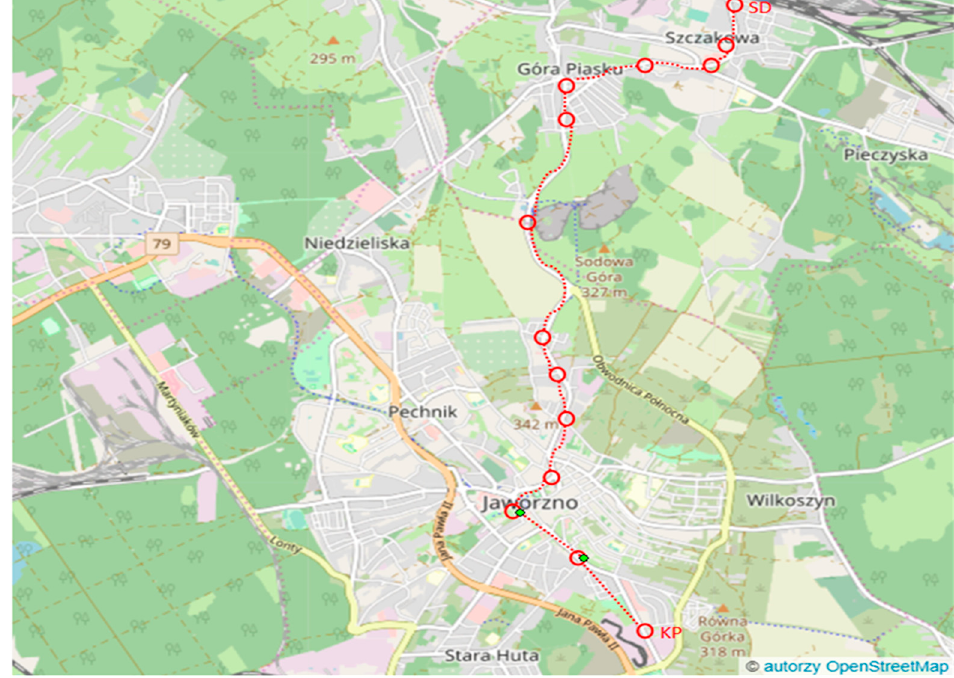
Figure 1. Route of an analysed bus line.